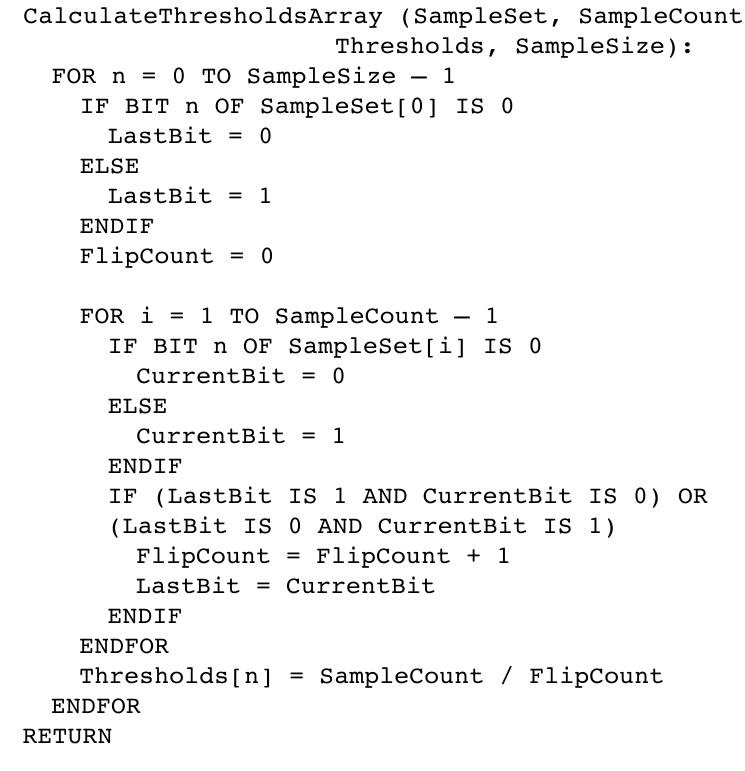
Fig. 10. C pseudo code for calculating the Threshold